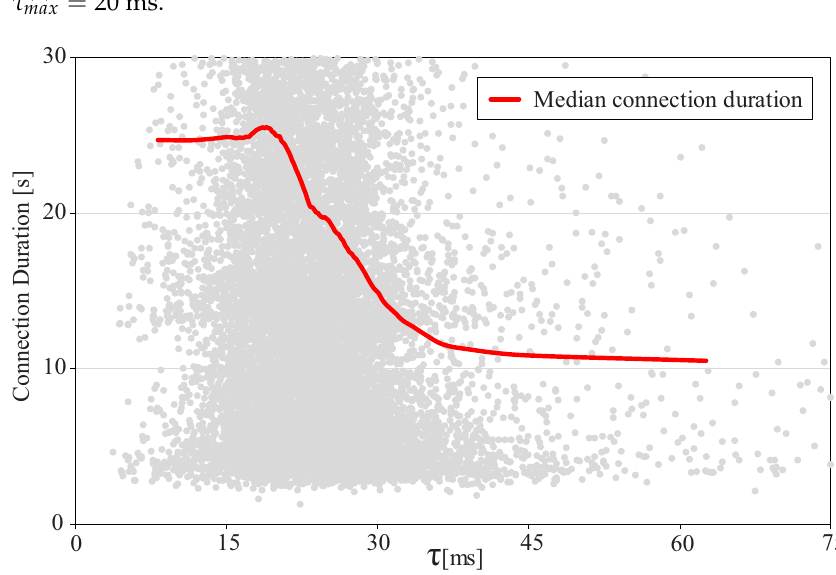
Figure 4. QoS and traffic indicators for a Voice over LTE (VoLTE)